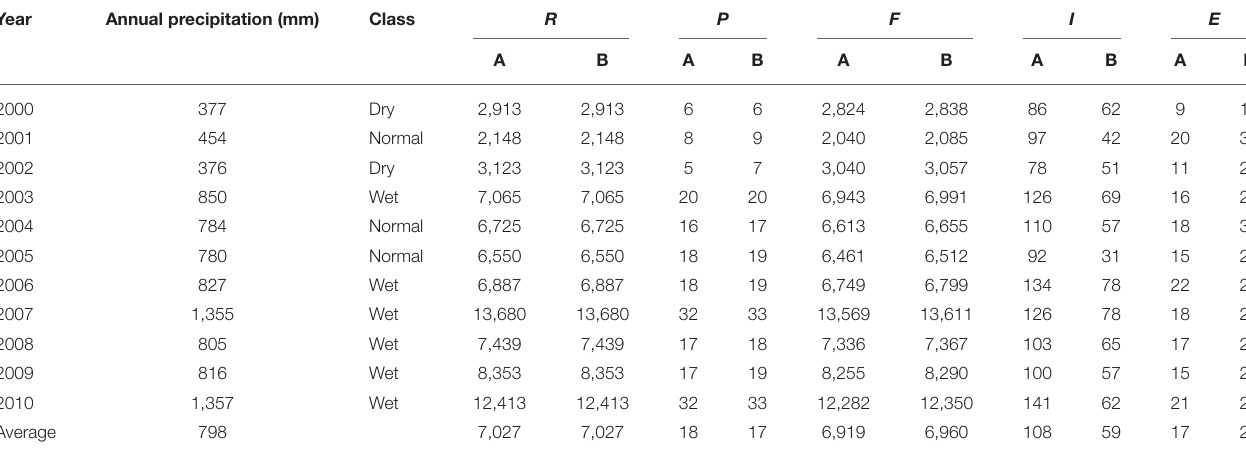
TABLE 2 | Annual water balance components (R, runoff; P, precipitation falling over the surface impounded area in the check dam; F, overflow; I, infiltration; E, evaporation, volumes in 1,000 m 3 ) for the two subsurface conditions (A and B). Year